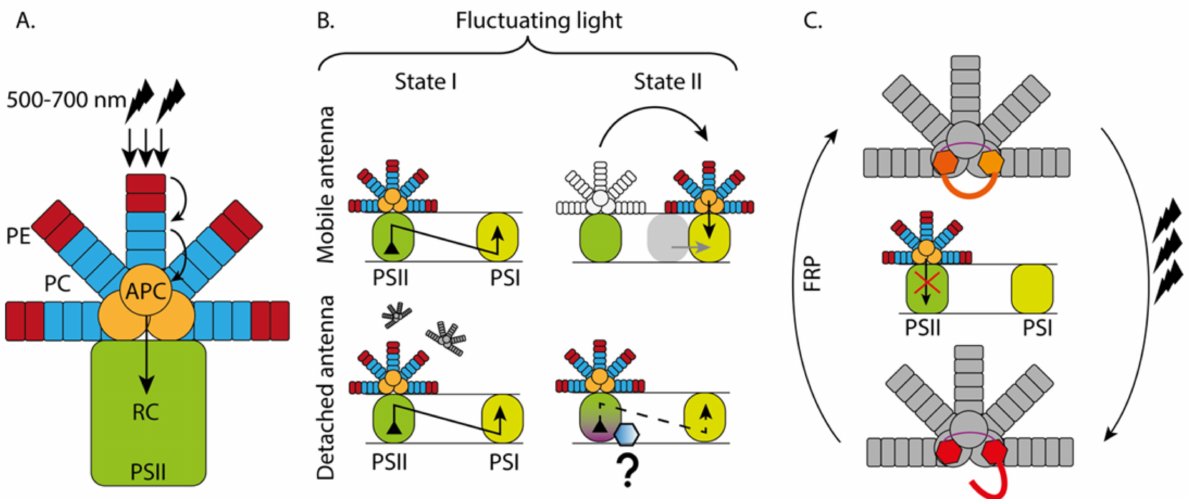
Figure 2. The functional properties of the cyanobacterial phycobilisome antenna (PBS) and orange carotenoid proteins (OCP) under fluctuating light conditions. ( A ) Structure of the PBS and the energy flow in the antenna system ( B ) Mobile and detached antenna models proposed for the acclimation of the light harvesting systems under fluctuating light regimes in the cyanobacteria (state transition). In the mobile antenna model, in state II, energy spillover is enabled by the physical contact of PSII with PSI. In the detached antenna model, in state II, the PBS remains with PSII that is quenched by a yet unidentified mechanism. ( C ) Excitation energy quenching by orange carotenoid proteins (OCP) in PSB. In high light, the conformation of OCP changes and excess energy is dissipated from the PBS. After the high light condition has passed, FRPs (fluorescence recovery proteins) bind to the red conformation of OCP, OCP dissociates from the PBS and the NPQ mechanism is turned off. ACP = allophycocyanin, PE = phycoerythrin, PC = phycocyanin, RC = reaction